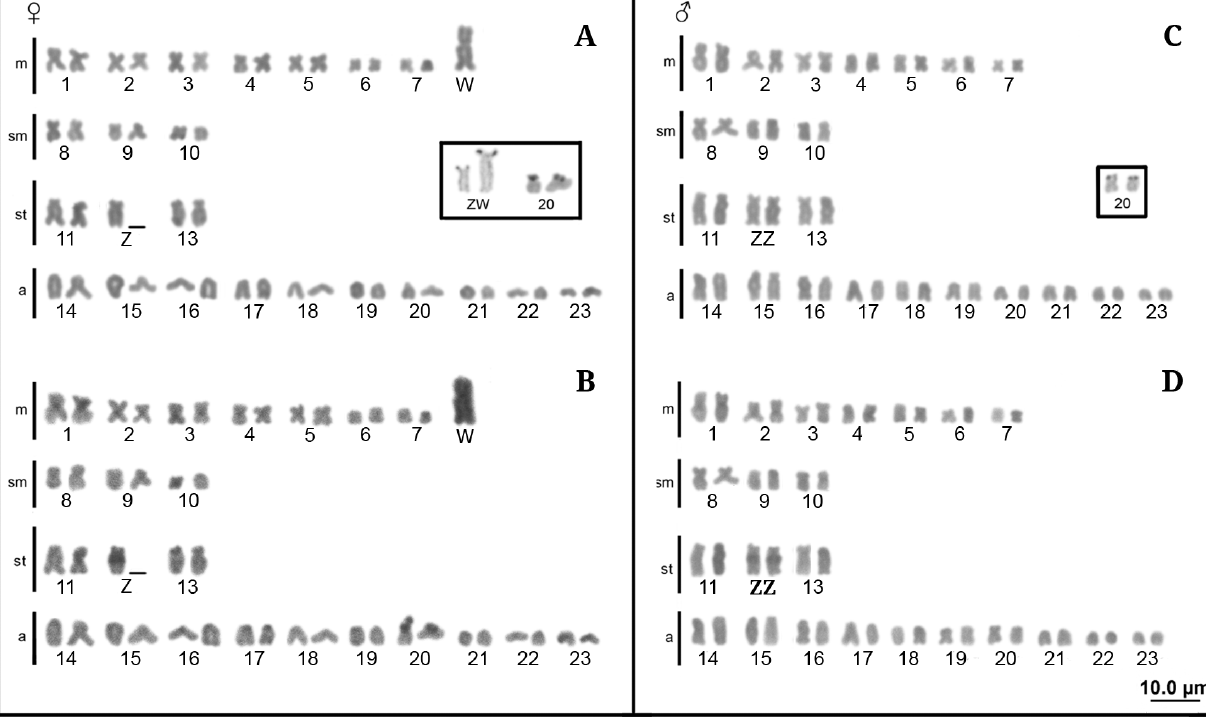
5/12 ni.bio.br | scielo.br/ni